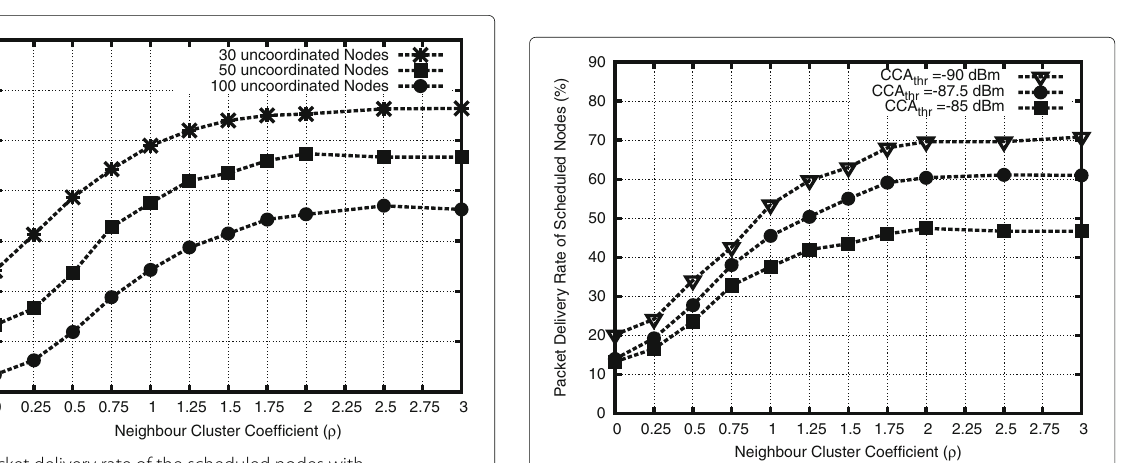
nodes, demonstrating that the term 1 /(cid:8) j ( s ) in Eq. (8) strongly impacts the goodput. On the other hand, when increasing ρ , larger priority is given to scheduled nodes having more neighbors, resulting in having more unco- ordinated nodes refrained from accessing the channel. Therefore, NG for uncoordinated nodes decreases with ρ .